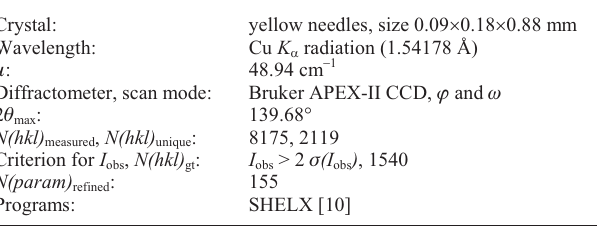
Table 1. Data collection and handling.